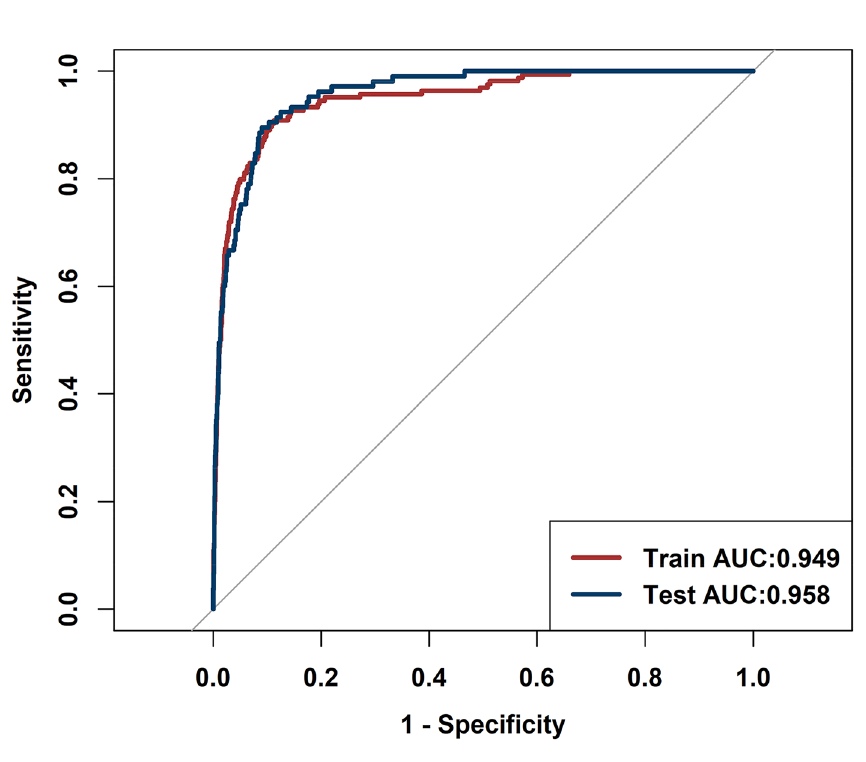
Figure 3. Model ROC